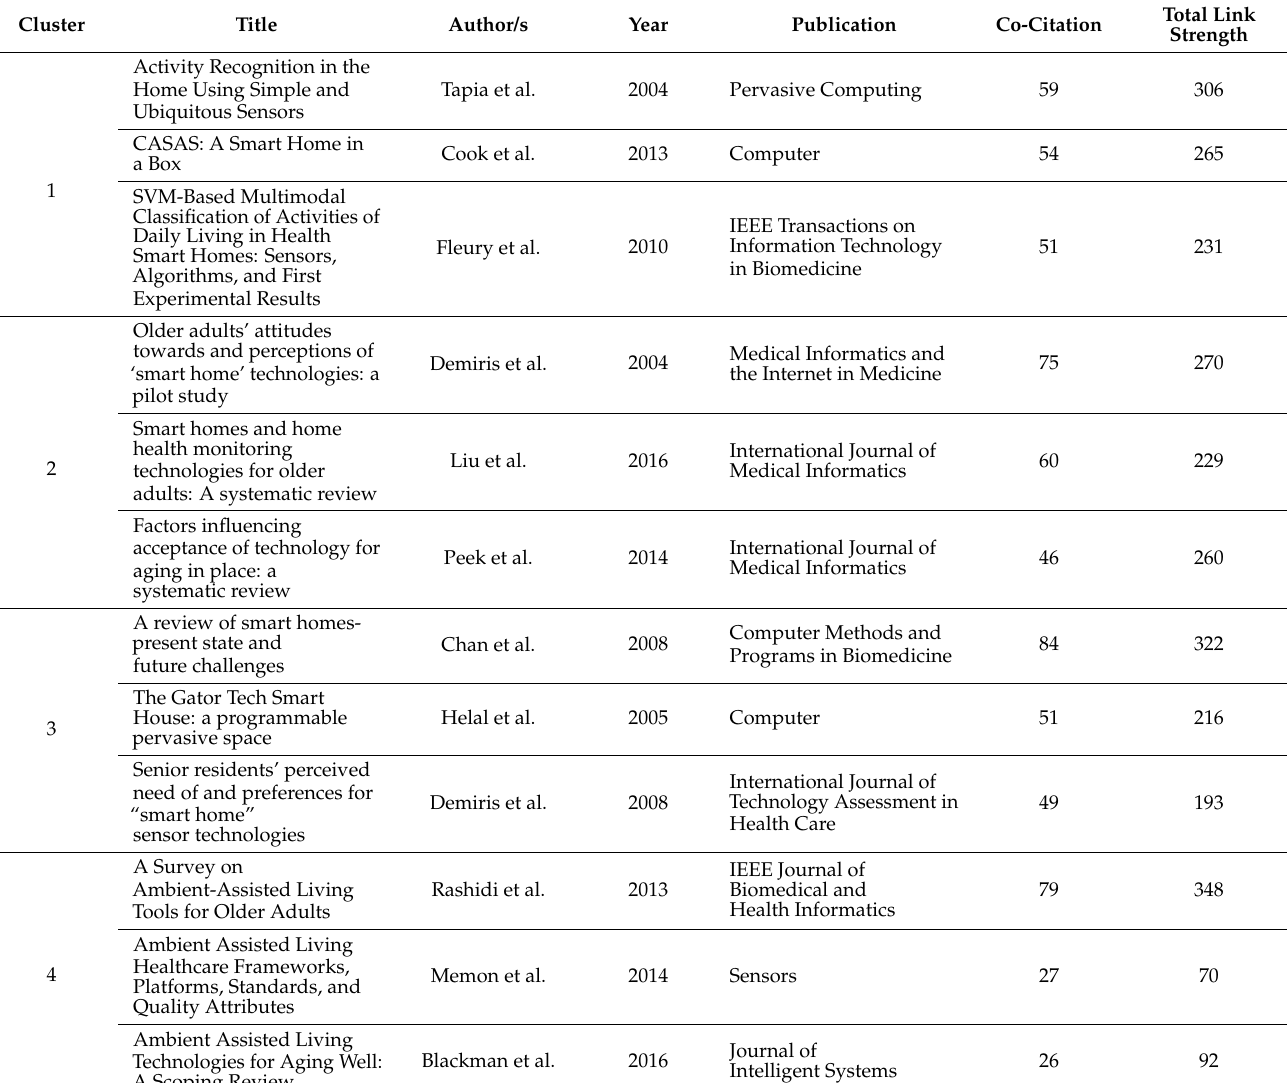
Table 8. Reference with high co-citation in SHOA